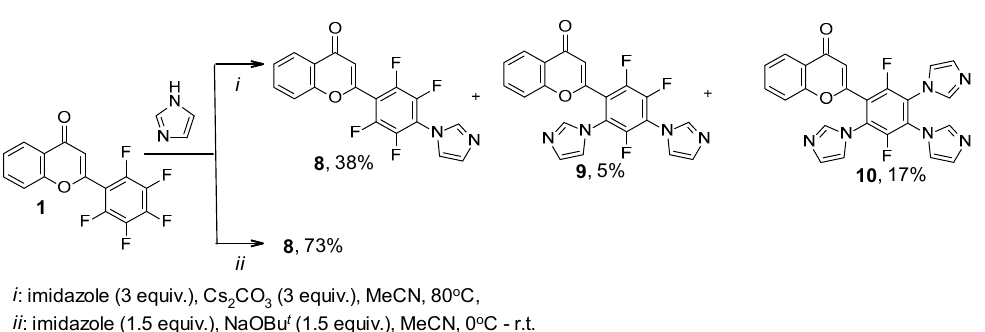
Table 2. 19 F NMR data of a mixture of Cs 2 CO 3 -promoted reaction of flavone 1 with imidazole. Compound